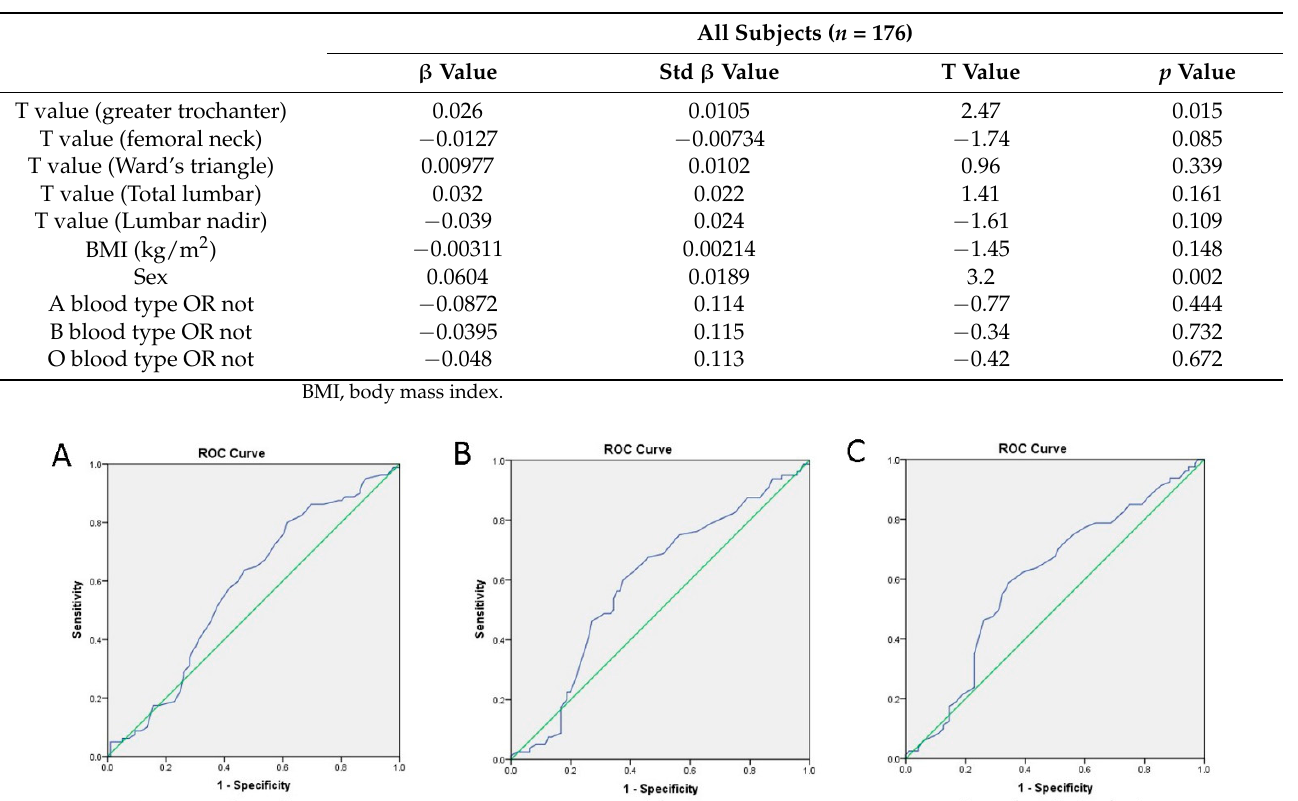
Table 2. Stepwise multiple linear regression analysis for the association between preoperative biomedical parameters and surgery blood loss volume in THA patients.